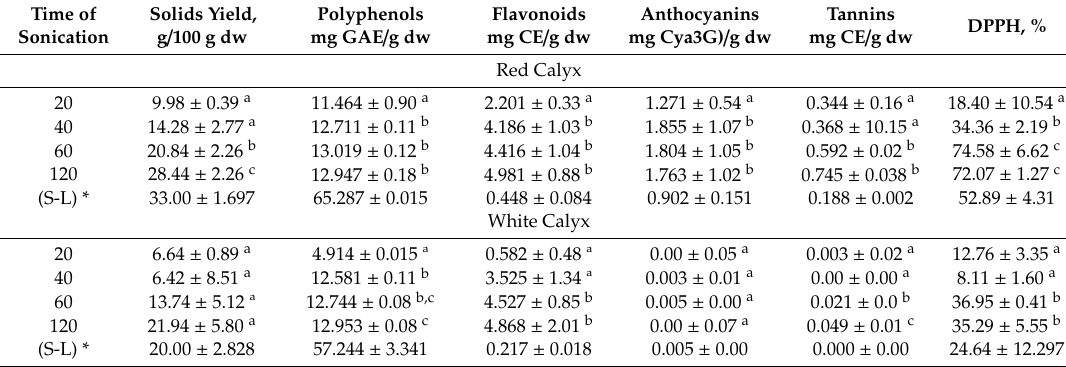
Table 1. Total polyphenols, anthocyanin, tannins and antioxidant activity (DPPH assay) of H sabdariffa at different sonication treatment time, solid: liquid ratio 1:20, solvent 80% ethanol, temperature 32 °C, power 180 W, frequency 40 kHz. Data are average of 3 treatments and presented as 𝑥̅ ∓ 𝑠 . Different letters are significantly different ( p < 0.05) Fisher ′ s Least Significant Difference (LSD), post hoc. Time of Solids Yield, Sonication g / 100 g